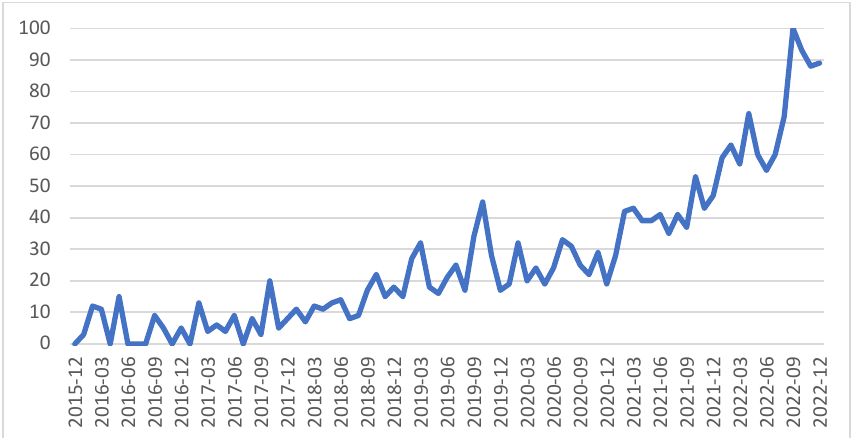
Figure 2. Google Trends for the term “Industry 5.0” in the period of 2015–2022 (Source: Google Figure 2. Trends).